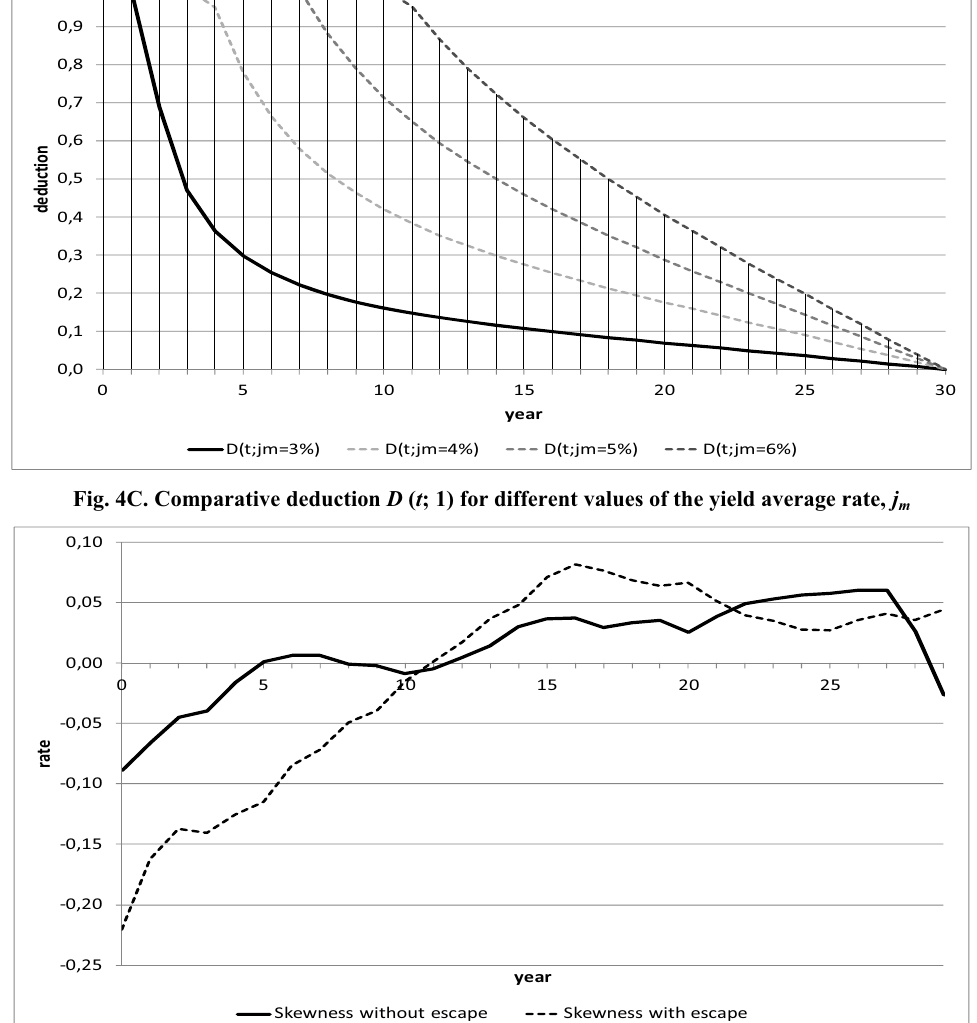
(cid:5) U evaluated in presence and in absence of contract t